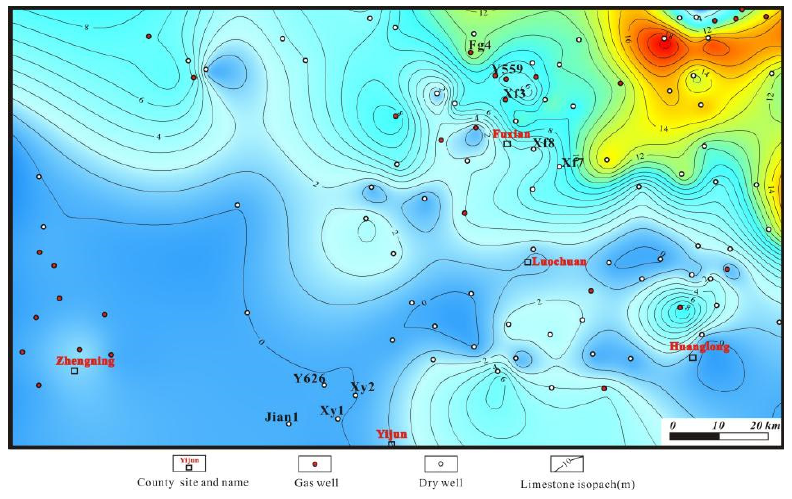
Figure 12. Limestone isopach map of the Taiyuan Fm. in the southeastern Ordos Basin.